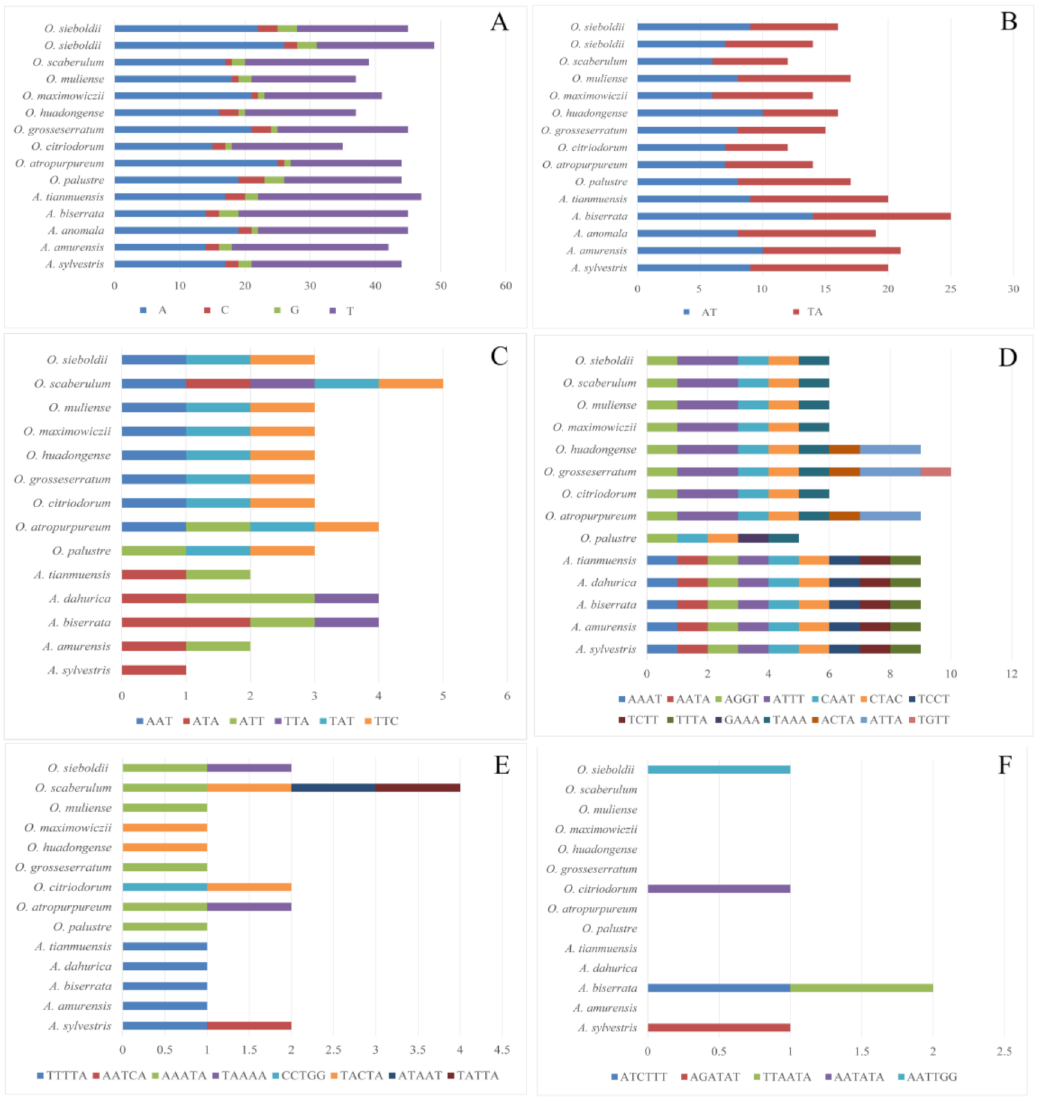
Figure 4. Repeat units of SSR types: ( A ) mononucleotide; ( B ) dinucleotide; ( C ) trinucleotide; ( D ) tetranucleotide; ( E ) pentanucleotide; and ( F )